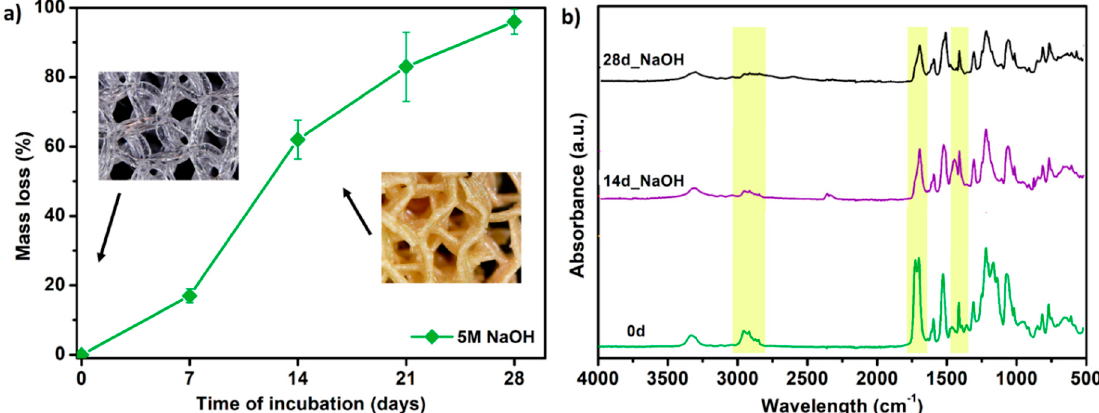
Figure 11. The results of accelerated degradation studies on G25 PTS in 5 M sodium hydroxide NaOH, ( a ) mass loss measurements, ( b ) FTIR spectra. SEM images showing the accelerated degradation process are presented in supplementary data (Table S7).